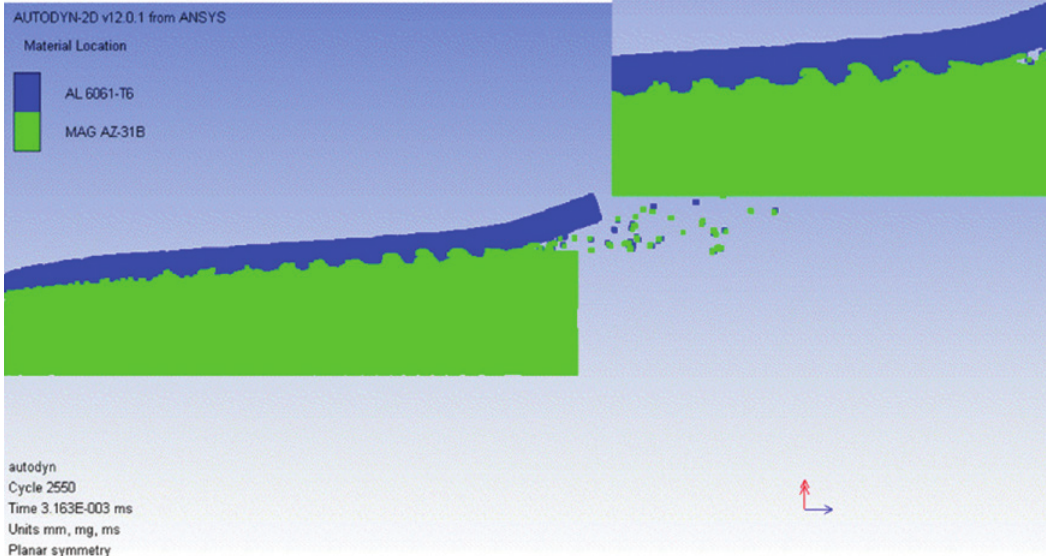
Figure 4: The material location of combination in the simulation.